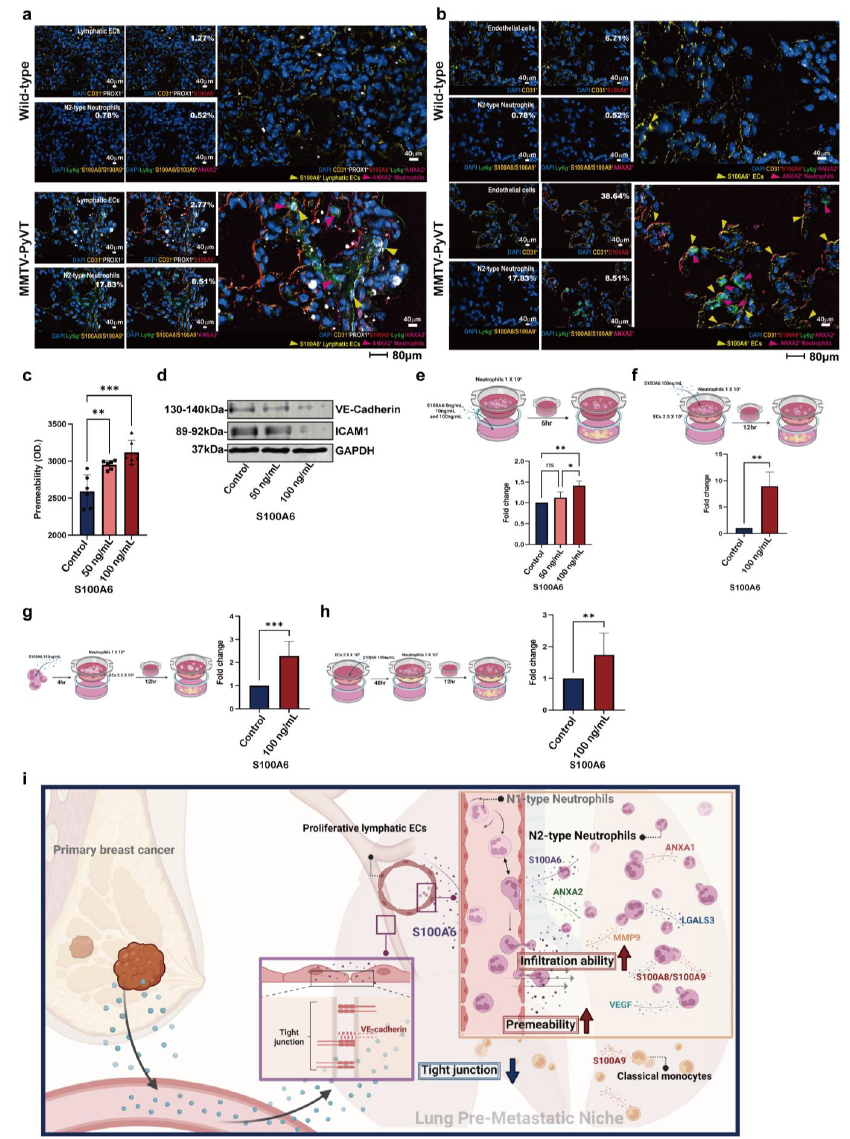
Figure 8. The roles of S100A6 in the vascular permeability and neutrophil recruitment. ( a ) The interaction between lymphatic ECs and N2-type neutrophils by S100A6-Anxa2 axis. The percentage of EC and neutrophil was indicated as a percentage of total CD31 + cell and total CD45 + cells, respec- tively. ( b ) Upregulated S100A6 expression in different cell types in the lungs of MMTV-PyVT mice. ( c ) S100A6 increased the vascular permeability of HULEC-5a. ( d ) S100A6 decreased the expression of tight junctions of HULEC-5a. ( e ) S100A6 cancer acted as a chemoattractant for migration. Neutrophils (1 × 10 6 cells) were seeded in an insert and S100A6 protein added into the bottom. After 6 hr, the migratory neutrophils were counted. ( f ) S100A6 increased neutrophil transendothelial movement. HULEC-5a cells were seeded in an insert to form confluent monolayer, neutrophils (1 × 10 6 cell) with or without S100A6 protein were added into the inserts. ( g ) S100A6 stimulated neutrophil migration. Neutrophil (1 × 10 6 cell) were seeded in an insert (3 µ m, 2.5 × 10 5 cells) and then treated with S100A6 protein for 4 h after 12 h the migratory neutrophils were counted. ( h ) S100A6 increased transendothelial migration of neutrophils by changing ECs. HULEC-5a were seeded in an insert (3 µ m, 2.5 × 10 5 cells) and then treated with S100A6 protein for 48 h. After washing, the inserts were suspended in a 24-well plate and neutrophils (1 × 10 6 cell) were added into the inserts for 12 h and migratory neutrophils were counted. ( i ) The proposed mechanism underlying the formation of the lung PMN in breast cancer. * p < 0.05, ** p < 0.01, *** p <